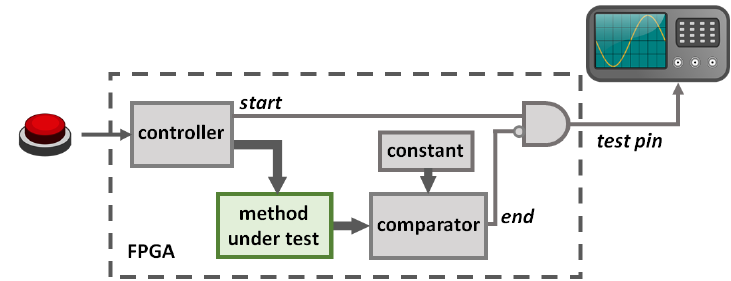
Figure 8. Measurement set-up for the field programmable gate array (FPGA) platform.